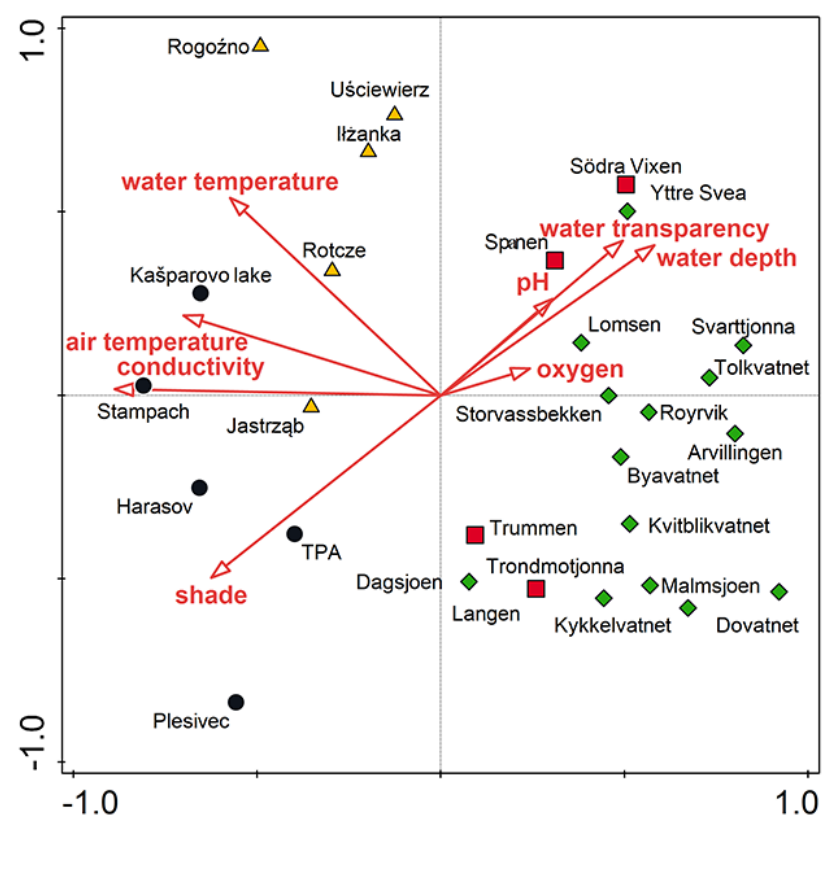
Figure 4 Mutual similarity of localities based on species composition correlated with environmental data. Localities of Potamogeton praelongus in the Czech Republic (black circles), central Poland (yellow triangles), Norway (green diamonds), and south Sweden (red squares). CCA analysis: e first axis explains 9% of the data variability and the first two axes together explain 16.14% of the data